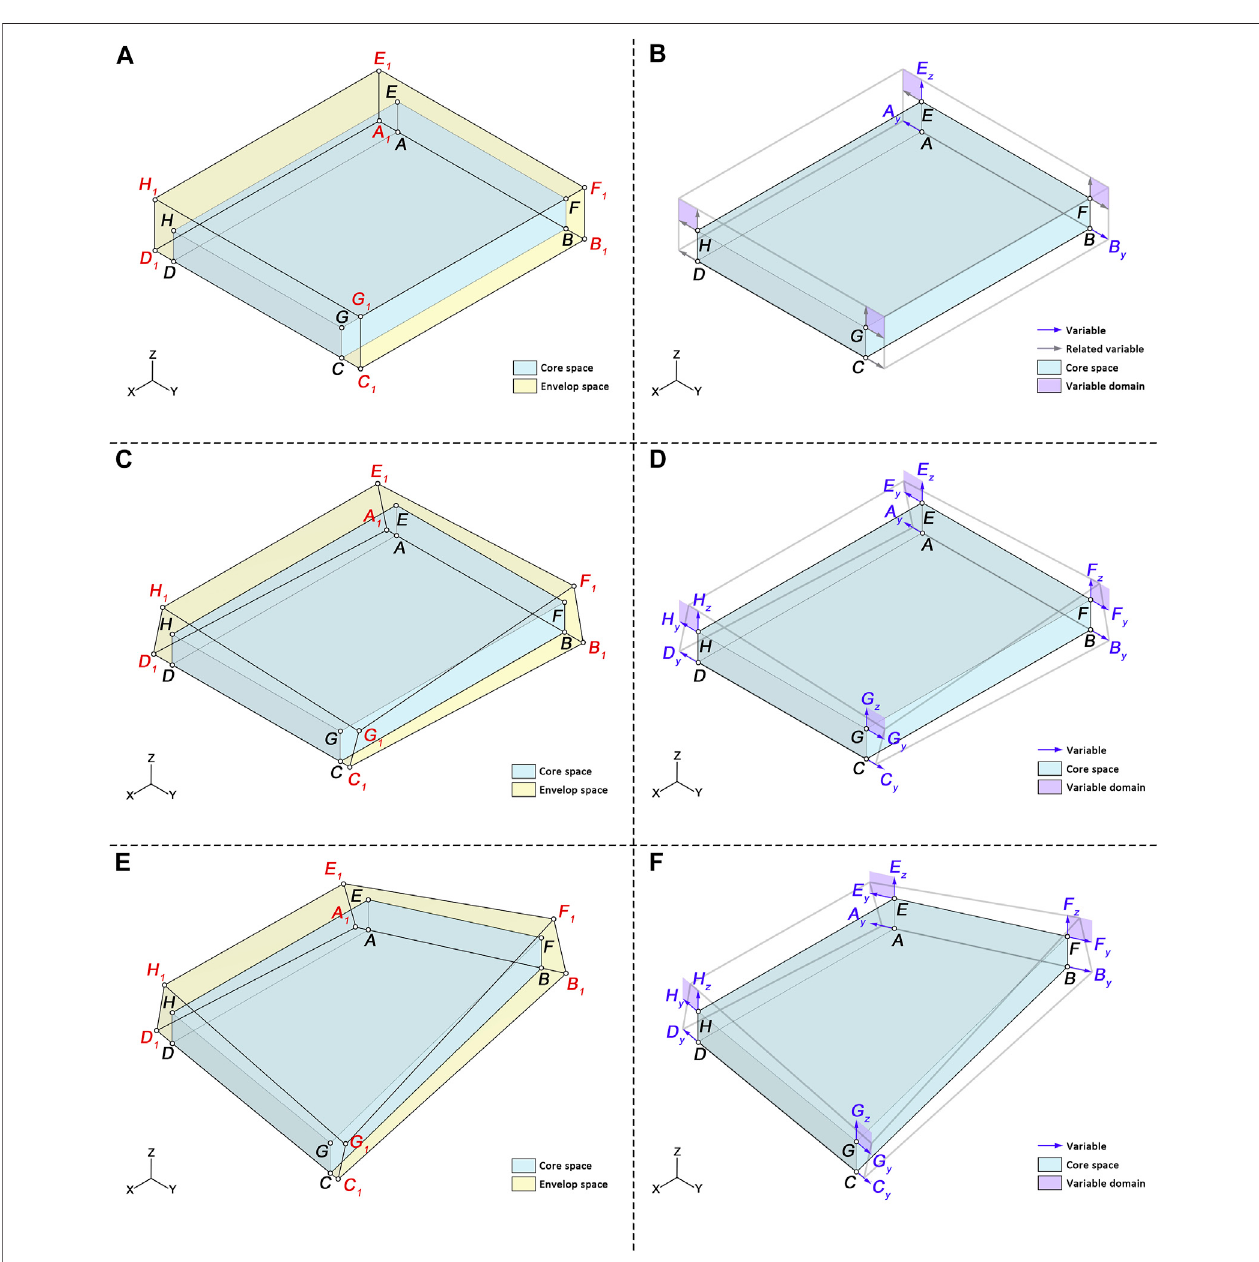
FIGURE 8 | Node systems and envelope variables of straight-edge shapes: (A) node systems of S1; (B) envelope variables of S1; (C) node systems of S2; (D) envelope variables of S2; (E) node systems of S3; (F) envelope variables of S3.